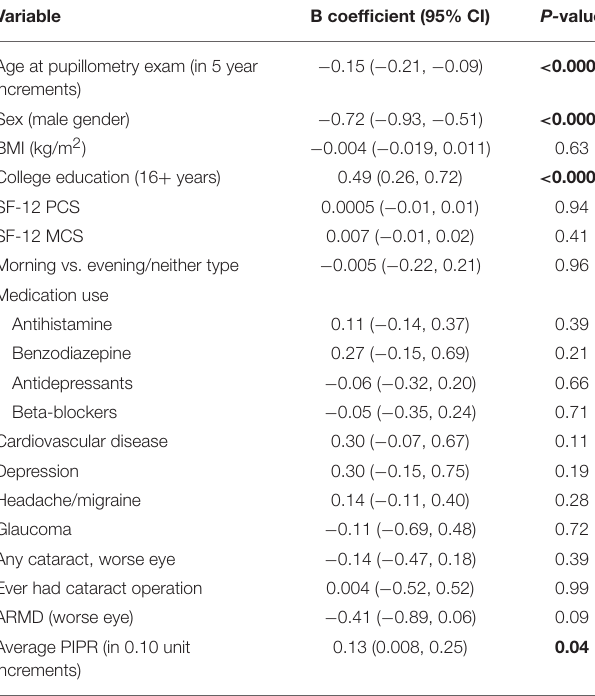
association between the PIPR and PCA summary score of the five cognitive measures ( n =